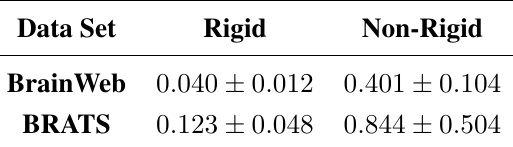
Table 5. Mean registration error when using multichannel images. Errors (mean ± standard deviation) are in